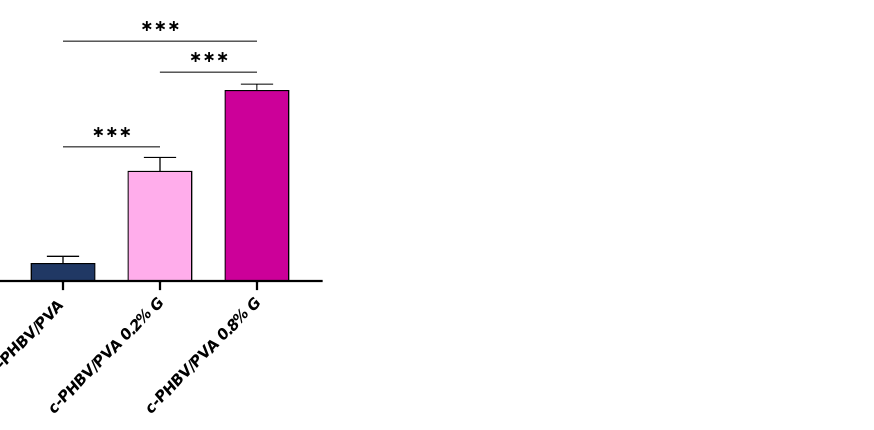
13 of 18 Figure 8. Dynamical mechanical analysis (compression mode). ( a ) Storage modulus ( E ′) and ( b ) loss modulus ( E ″) at 37 °C for c-PHBV/PVA and nanohybrid hydrogels with 0.2% and 0.8% of G nanosheets. Crosslinked PVA (c-PVA) is included as reference. Graph shows mean ± standard devi- ation; (****) indicates significant differences ( p < 0.001). The electrical surface conductivity, obtained by equation (3) and depicted in Figure 9, shows a statistically significant increase ( p < 0.001) after the addition of G nanosheets compared to the semi-IPN without nanoparticles as expected. Significant differences were also found between nanocomposites with 0.2% and 0.8% of G nanosheets ( p < 0.001). The conductivity increases more than 600% after the addition of 0.2% of nanofiller (from 5.0 to 30.7 mS/m). When 0.8% of G nanosheets are added, the surface conductivity increases to